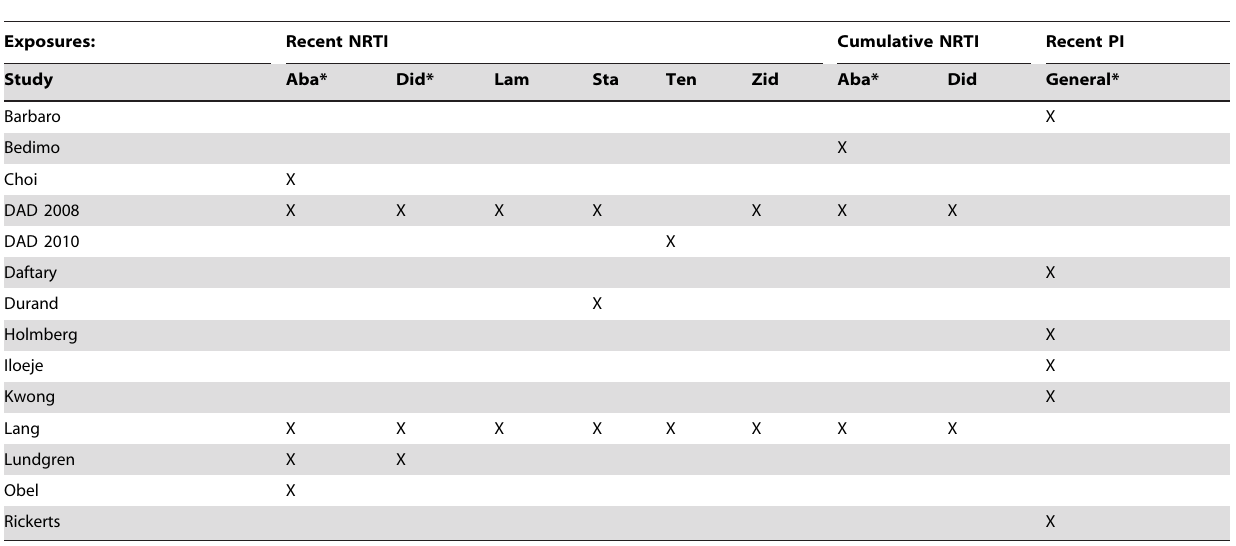
Table 3. Supplemental Summary of Association by P-Value.